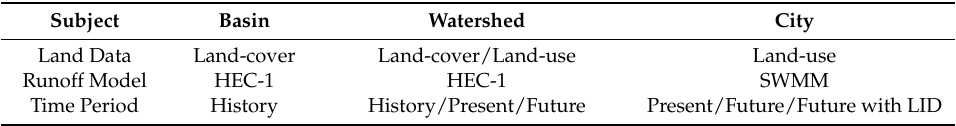
Table 1. Study subjects on different scales.